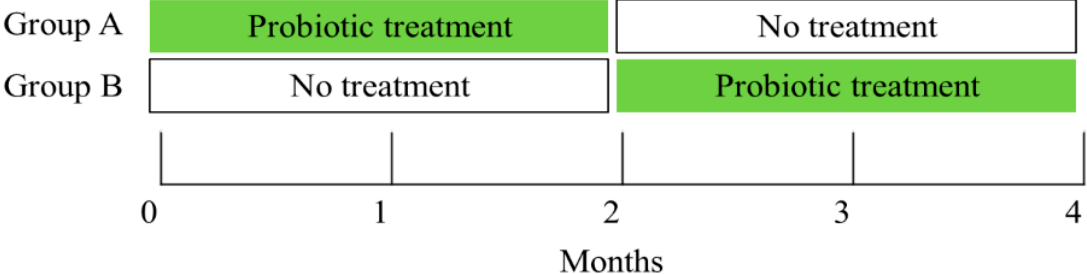
Figure 1. Timetable for schedule of treatment and assessments. At baseline (point 0) and every